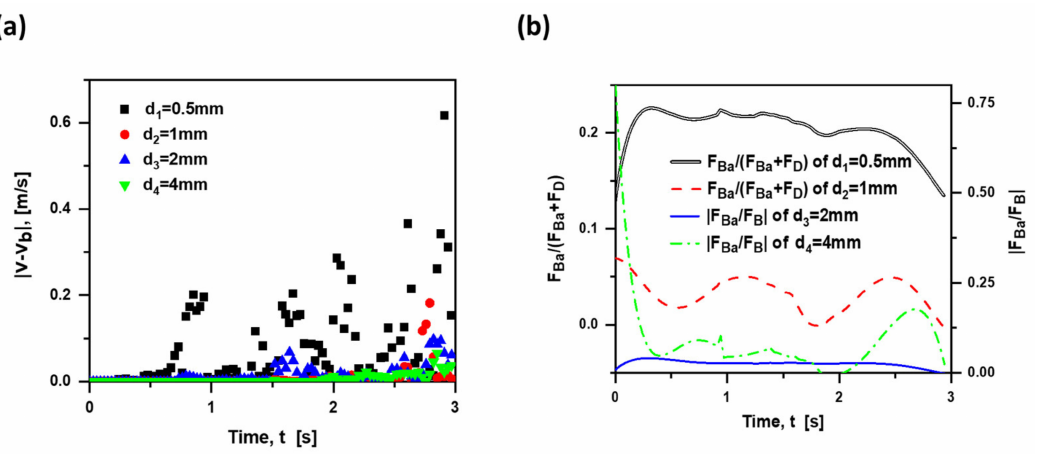
Figure 10. ( a ): Absolute difference in rising velocity between the case with and without Basset force of four diameters; ( b ):